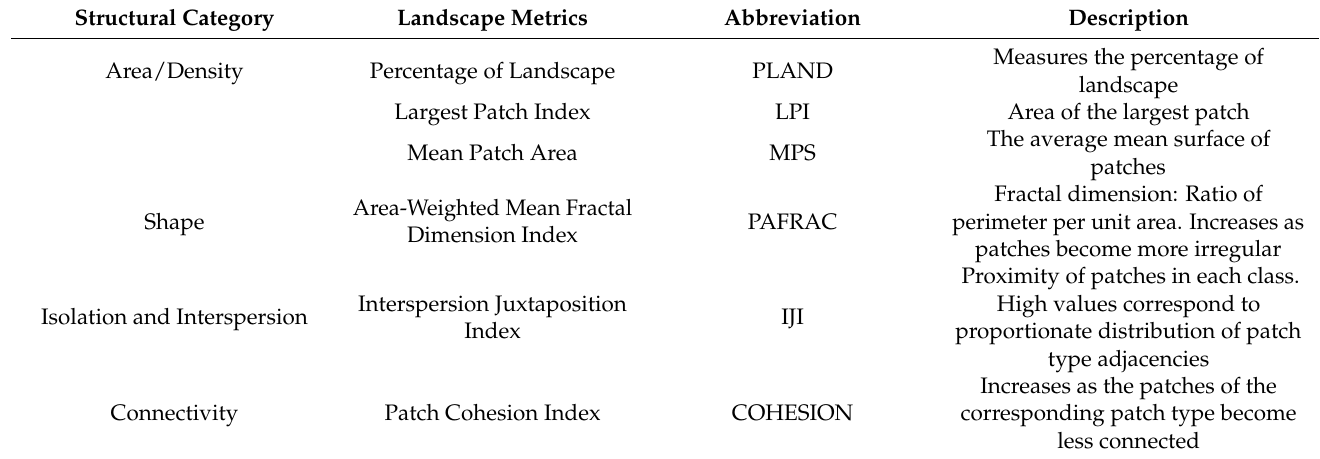
Table 2. Description of landscape configuration metrics